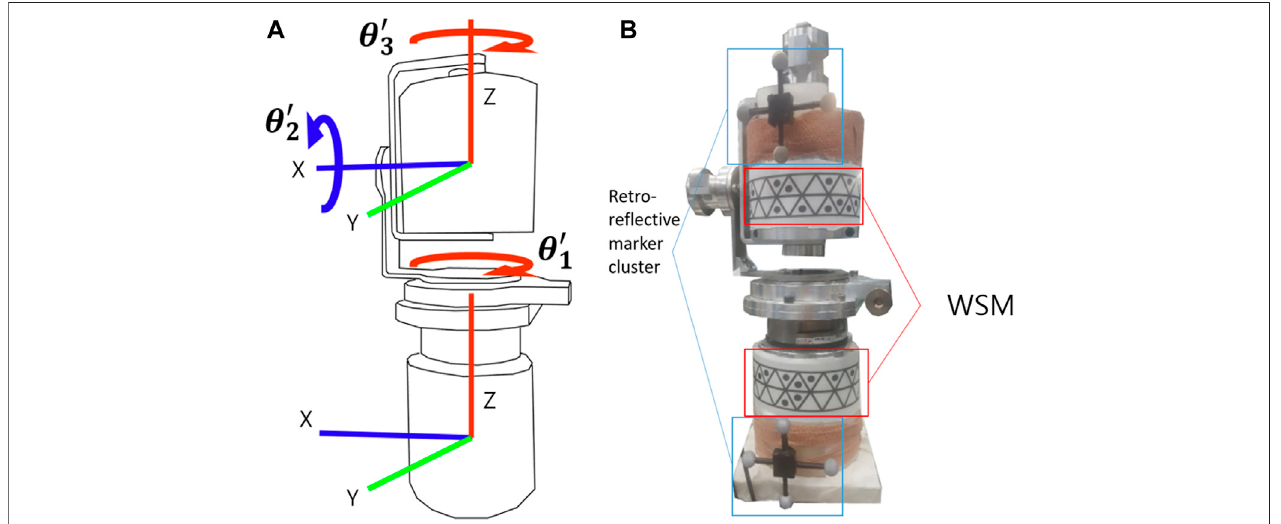
FIGURE 8 | (A) Schematic of the gimbal coordinate system. The gimbal had 3 DOFs, and the joint angles were obtained by measuring the position of the upper segment relative to the lower segment. (B) Retrore fl ective cluster and WSM placement on the gimbal. Each cluster and WSM had de fi ned coordinates.